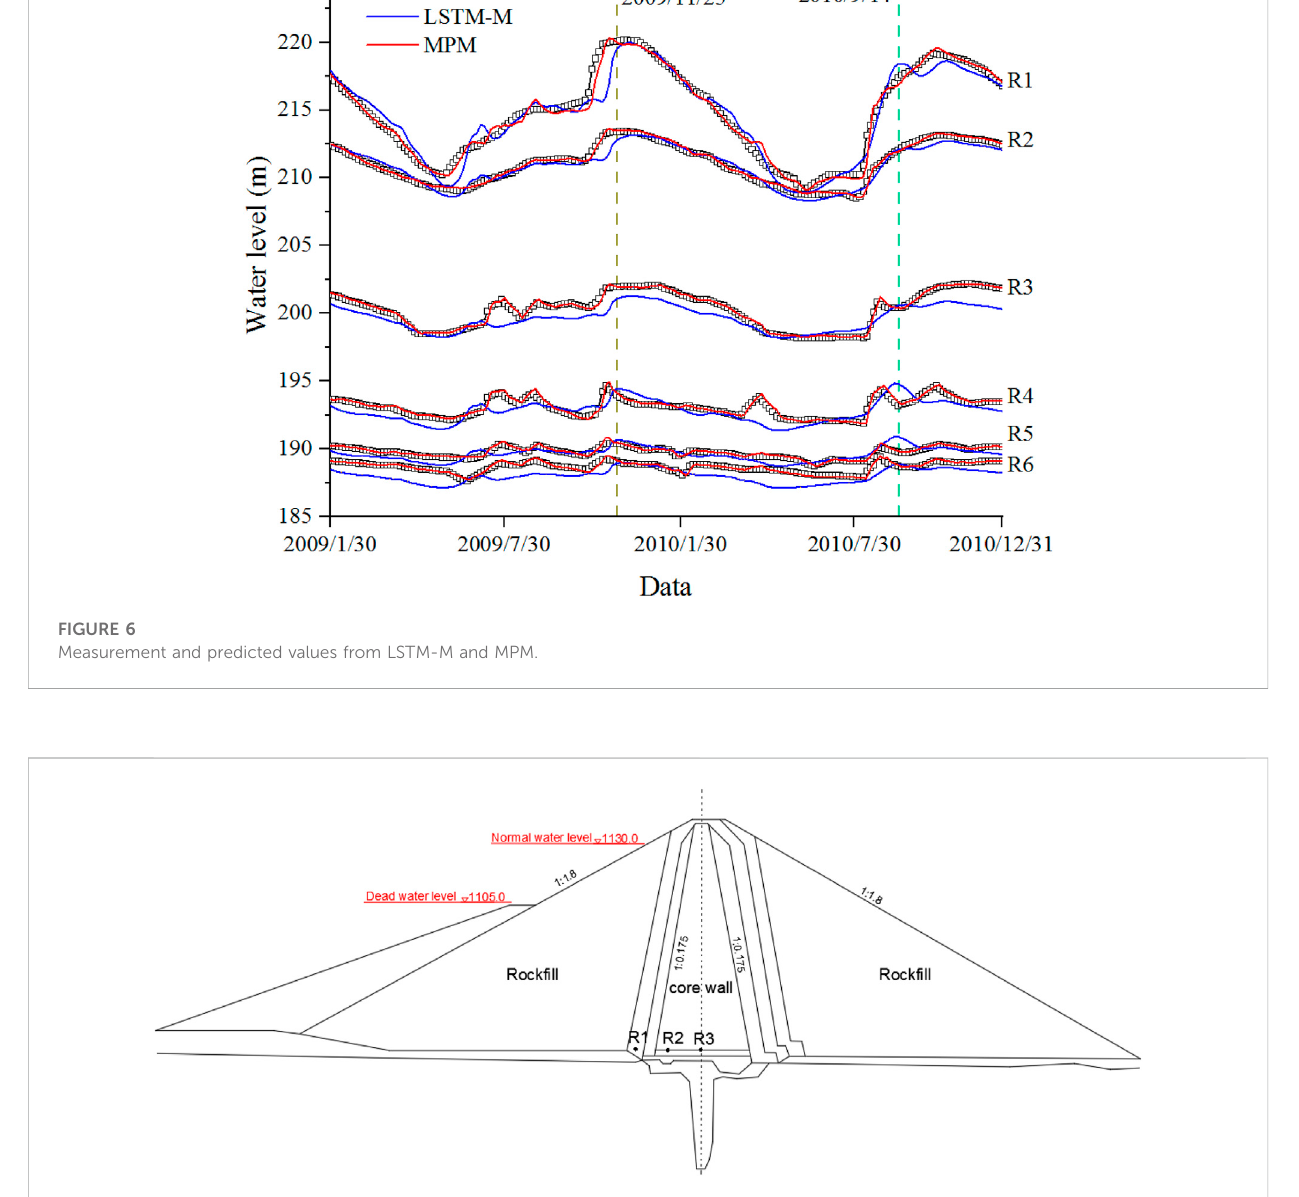
FIGURE 7 Osmometers distribution of the Lubuge rock fi ll